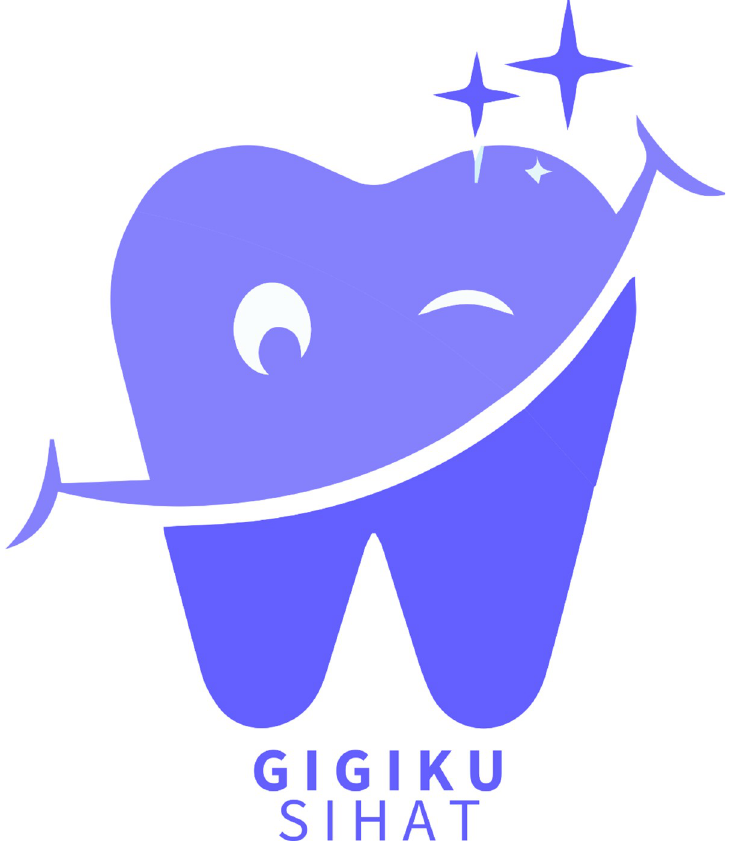
Fig 4. Gigiku Sihat